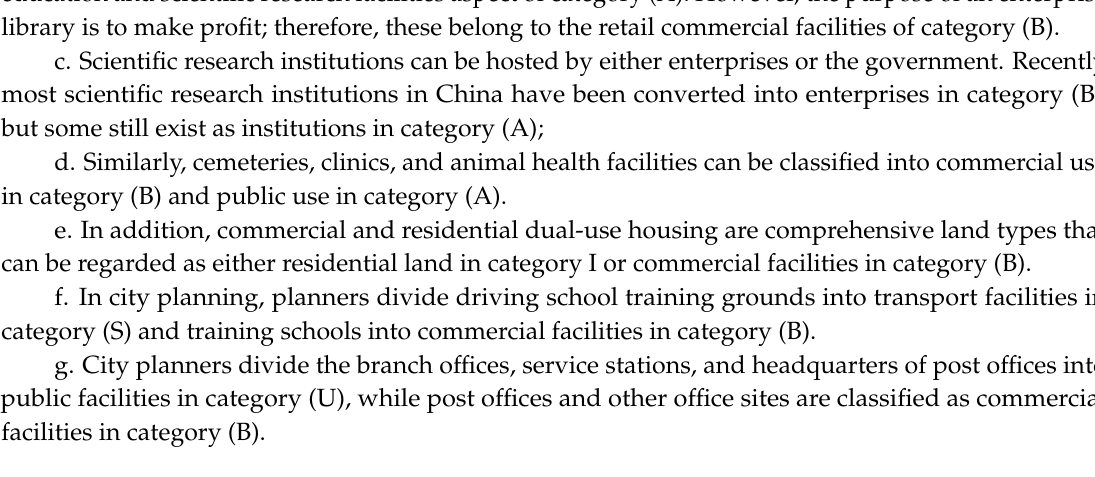
Table 3. The set of betweenness